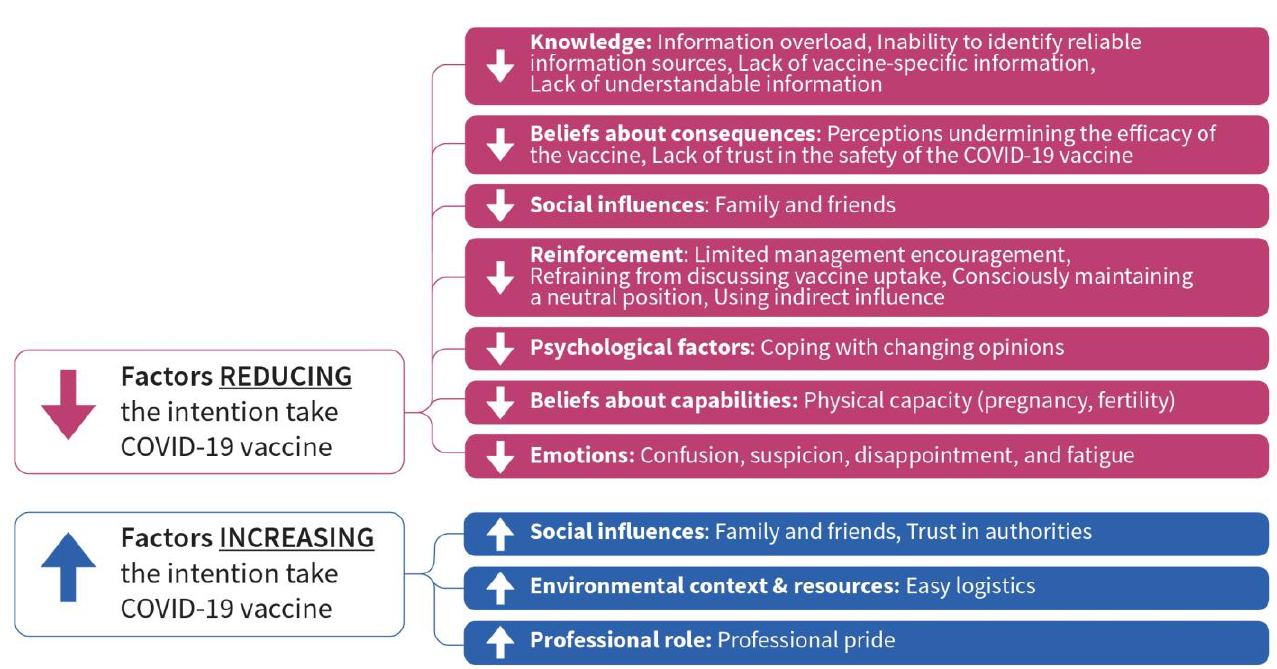
Figure 1. TDF domains that increase and decrease uptake of COVID-19 vaccine among nursing staff in LTCF.